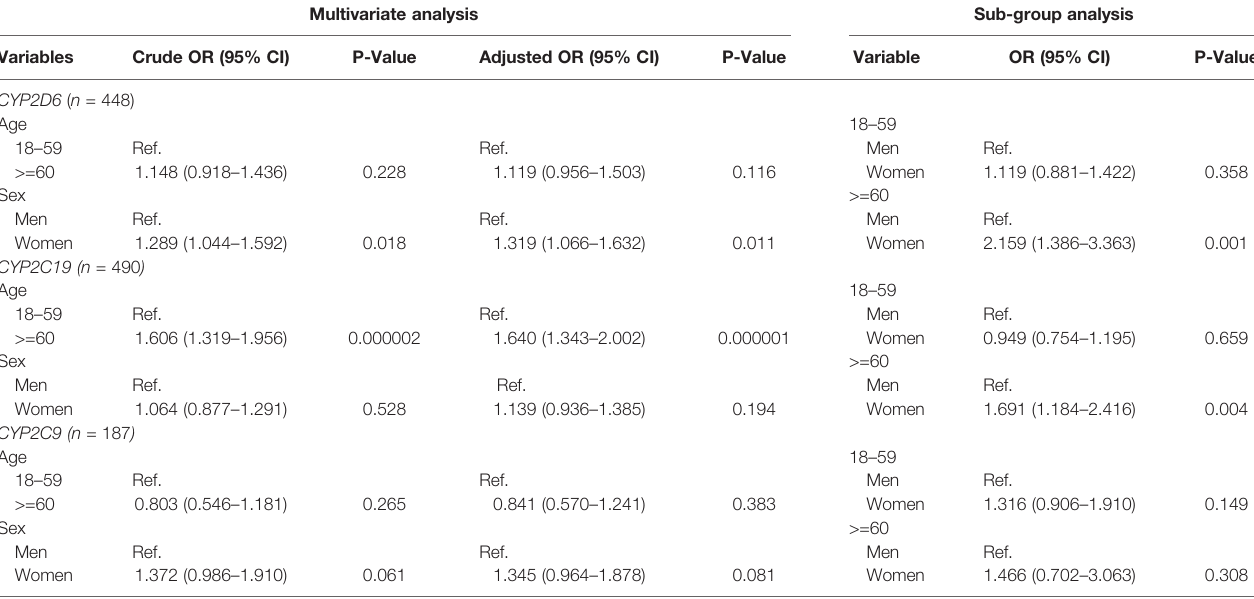
TABLE 3 | Multivariate analysis on the in fl uence of age and sex on risk of having potential CYP2C9/2D6/2C19 mediated DDIs. Multivariate analysis